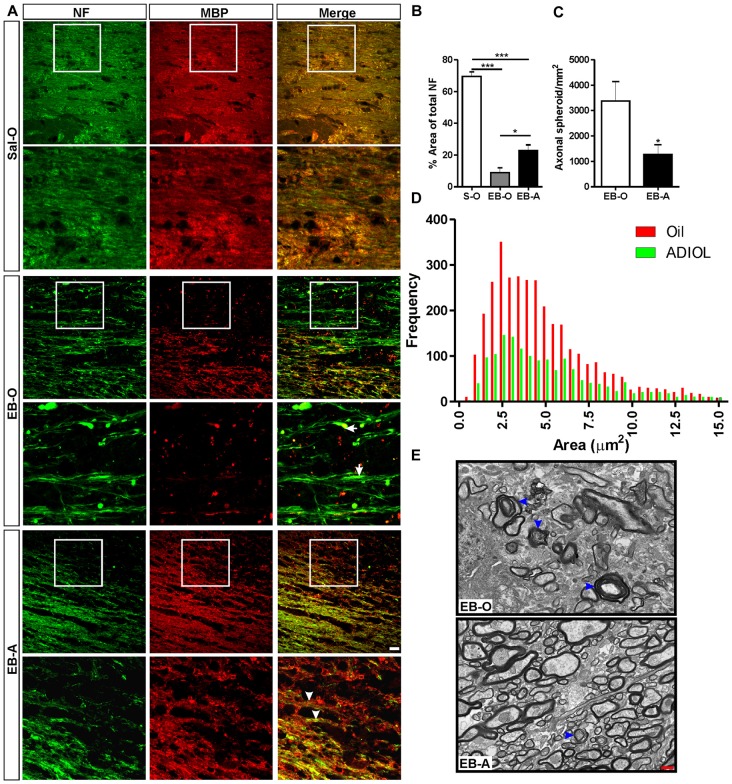
Effect of ADIOL on axonal damage 7 days post-EB-induced demyelination. (A) Immunofluorescent staining of NF (green) and MBP (red) in corpus callosum 7 days post-EB injection. EB injection resulted in a reduction in the density of NF+ fibers in the EB-O group (EB-O panel) compared to rat group given intra-corpus callosum injection of saline (Sal-O panel). Axonal spheroids indicative of axonal damage are more frequently observed in the EB-O group (EB-O panel) compared to the EB-A group (EB-A panel). (B) Bar graph presents the percentage area covered by NF+ fibers. EB injection significantly reduced the density of NF+ fibers in the vicinity of the demyelinated corpus callosum when compared to saline-injected animals (Sal-O: n = 4, EB-O: n = 5, EB-A: n = 8, p < 0.001). ADIOL treatment significantly increased the density of NF+ fibers compared to that seen in EB-O rat group (p < 0.05). (C) Bar graph shows the count of axonal spheroids in the vicinity of the EB-induced lesion. ADIOL significantly reduced the number of these spheroids compared to oil-treated animals (EB-O: n = 6, EB-A: n = 10, p < 0.05). (D) The histogram shows the frequency distribution of axonal spheroids according to their sizes. Most spheroids observed were of sizes ranging from 1 μm2 to 7.5 μm2. ADIOL reduced the frequency of these spheroids in the vicinity of corpus callosum when compared to oil-treated rats. (E) Transmission electron micrographs of the EB-injected corpus callosum of oil-treated and ADIOL-treated animals. Signs of myelin sheath detachment from axons are more apparent in the oil-treated animals (arrowheads in the upper micrograph) compared to those seen in ADIOL-treated ones (lower micrograph). *p < 0.05, ***p < 0.001. All data are presented as mean ± SEM. Scale bar for immunofluorescence images = 50 μm. Scale bar for transmission electron microscopy (TEM) images = 1 μm.